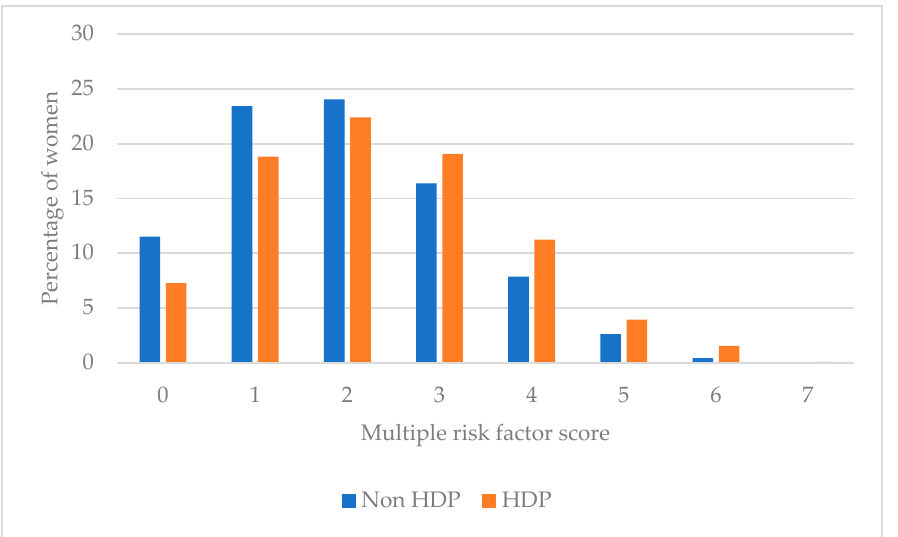
Figure 2. Multiple modifiable risk factor scores among women with and without HDP. Table 4. Multiple modifiable risk factor scores among women with and without HDP.